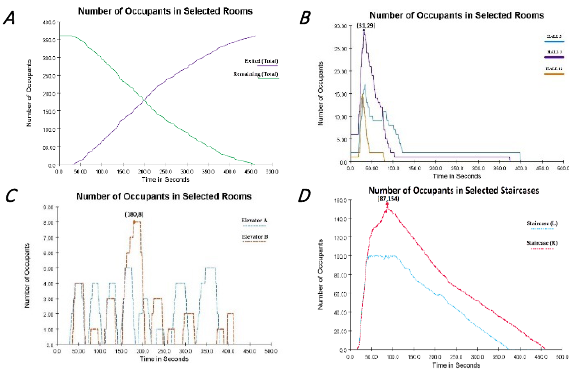
Figure 6. Evacuation results in Stereen mode All elderly and disabled people in wheelchairs reached the safe area in 413 seconds. Table 4 shows the results and statistics data of the Steering mode.